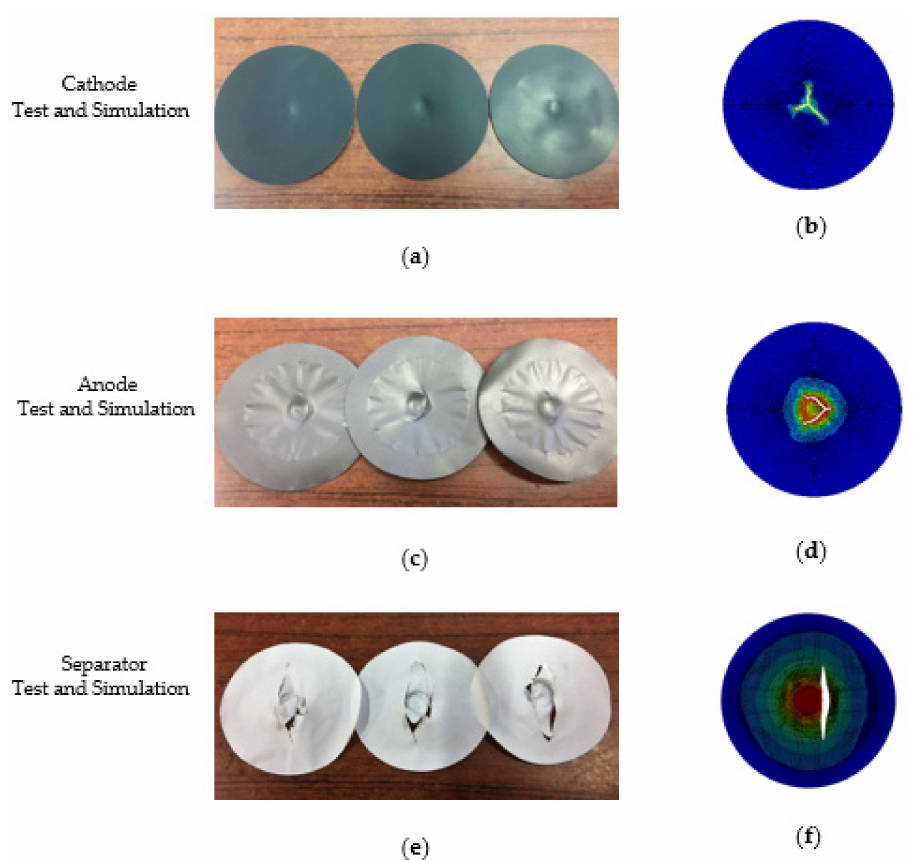
Figure 9. Failure mode of lithium-ion prismatic cell components under spherical punch: ( a ) Cathode test results; ( b ) Cathode simulation results; ( c ) Anode test results; ( d ) Anode simulation results; ( e ) Separator test results; ( f ) Separator simulation